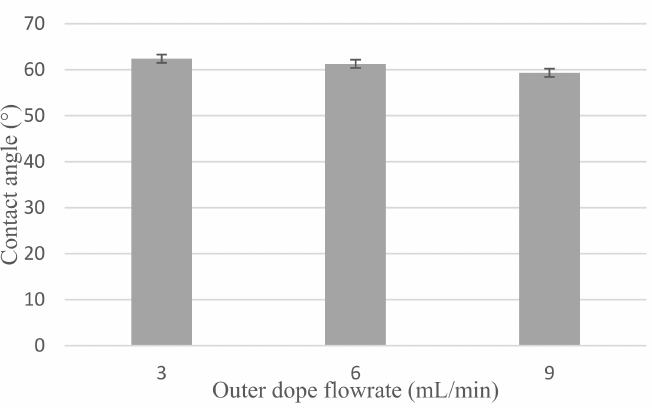
Figure 4. Contact angle for 0.25 Cu 2 O/PVDF DLHF membrane for 3 mL/min, 6 mL/min and 9 mL/min outer dope